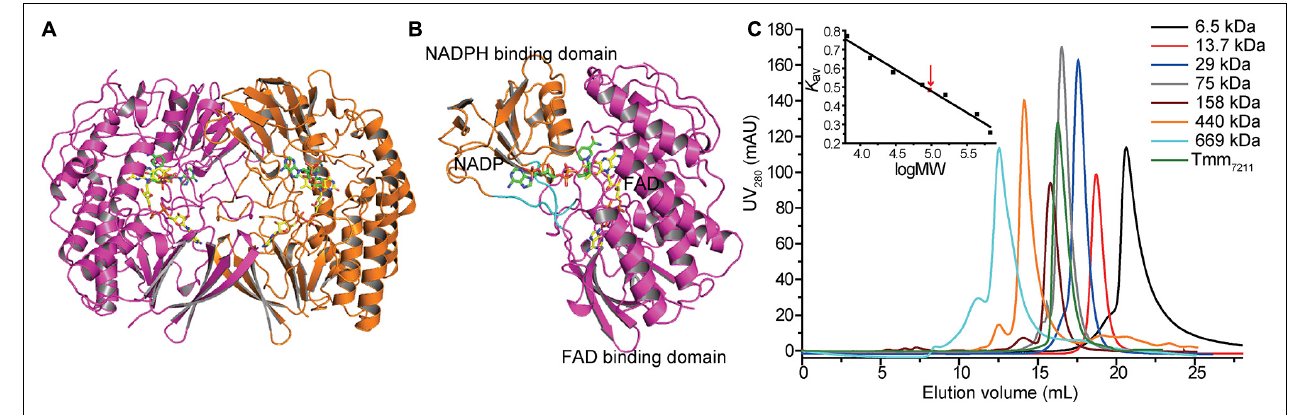
FIGURE 2 | Overall structure of Tmm 7211 . (A) Two monomers of Tmm 7211 arranged as a dimer in an asymmetric unit. The monomers are colored in magenta and orange, respectively. (B) The overall structure of Tmm 7211 monomer. Tmm 7211 contains an NADPH binding domain (colored in orange) and a FAD binding domain (colored in magenta) connected through two hinge regions (colored in cyan). The NADP + molecule and the FAD molecule are shown as sticks colored in green and yellow, respectively. (C) Gel filtration analysis of Tmm 7211 . Inset, semilog plot of the molecular mass of all standards used vs. their K av values (black squares). The red arrow indicates the position of the K av value of Tmm 7211 (0.48) interpolated in the regression line. Tmm 7211 monomer has a calculated molecular mass of 52 kDa. The apparent molecular mass of Tmm 7211 is 95 kDa, indicating that Tmm 7211 is a dimer in